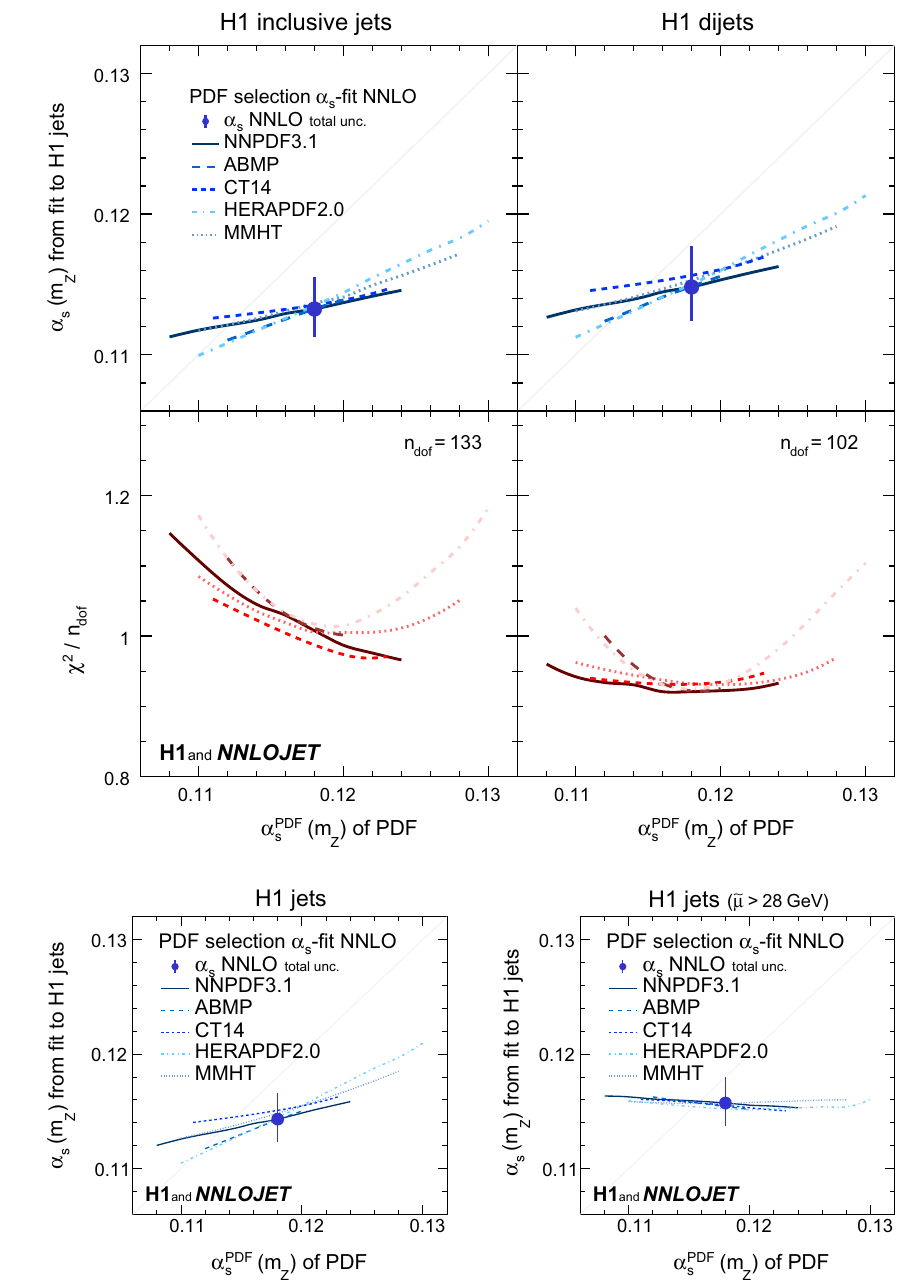
to inclusive jet and to dijet cross sections are displayed in Fig. 6 indicating that the standard choice for the scales (unity scale factor) yields reasonable values of χ 2 / n dof . Figure 7 displays the resulting α s ( m Z ) for fits to H1 jets. In general, variations of μ R have a larger impact on the result than those of μ F . When restricting the data to ˜ μ > 28 GeV, the scale dependence is greatly